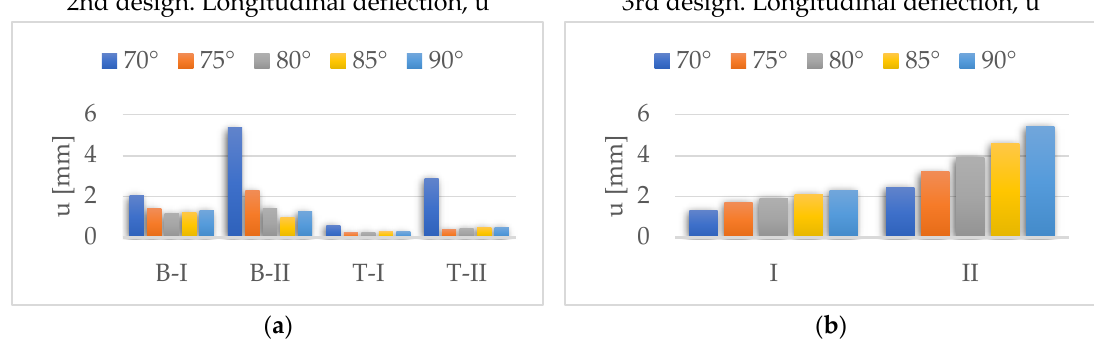
Figure 15. Evolution of maximum longitudinal deflections, u, with α, for designs: ( a ) 2nd; ( b ) 3rd. Figure 16 shows the vertical and longitudinal deflections found for the fourth design. The former have a minimum for α = 80° and the latter for α = 75°. However, since the vertical deflections are better for α = 80°, we consider this the best angle.